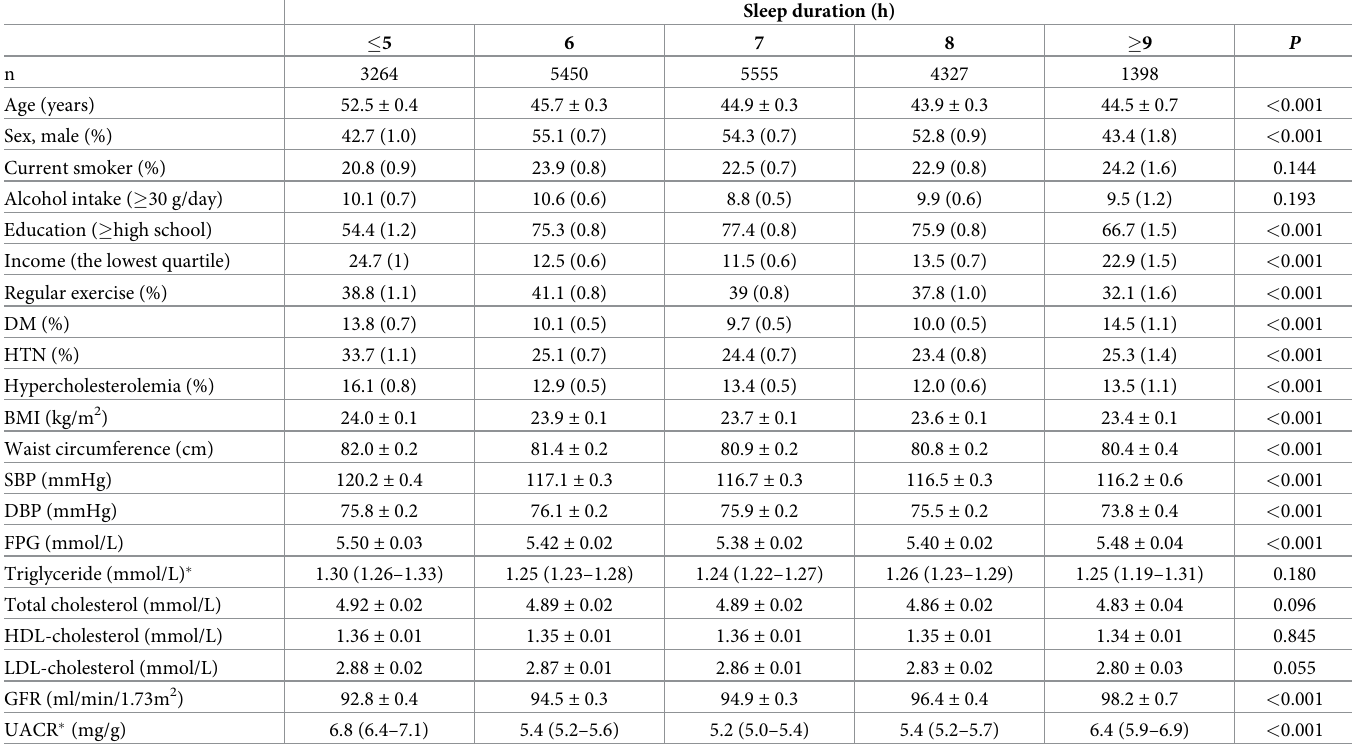
Table 1. Clinical characteristics of study subjects according to sleep